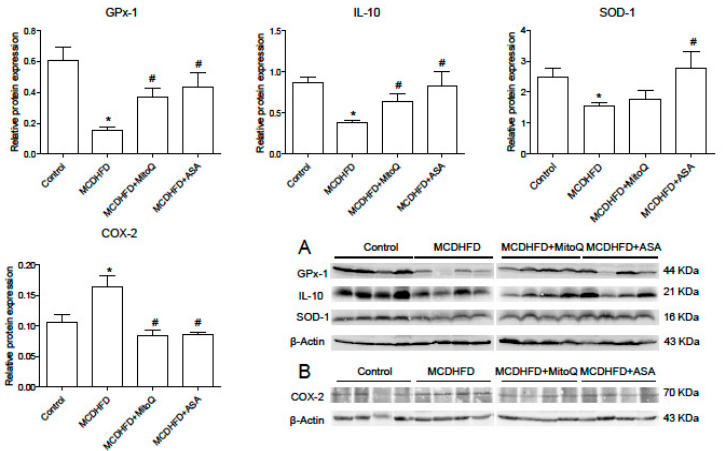
Figure 5. Protein expression of (A) GPx-1, SOD-1, IL-10, and (B) COX-2 in livers from control, MCDHF, MCDHF + MitoQ, and MCDHF + ASA mice. * p < 0.05 vs. control; # p < 0.05 vs. MCDHF. The experiments were performed in triplicate. In MCDHFD animals, GPx-1, SOD-1, and IL-10 he- patic expression was impaired compared to controls. Treatment with MitoQ and ASA both in- creased the expression of GPx-1 and IL-10, while only ASA increased the expression of SOD-1. In MCDHFD mice, both MitoQ and ASA normalized the expression of COX-2.